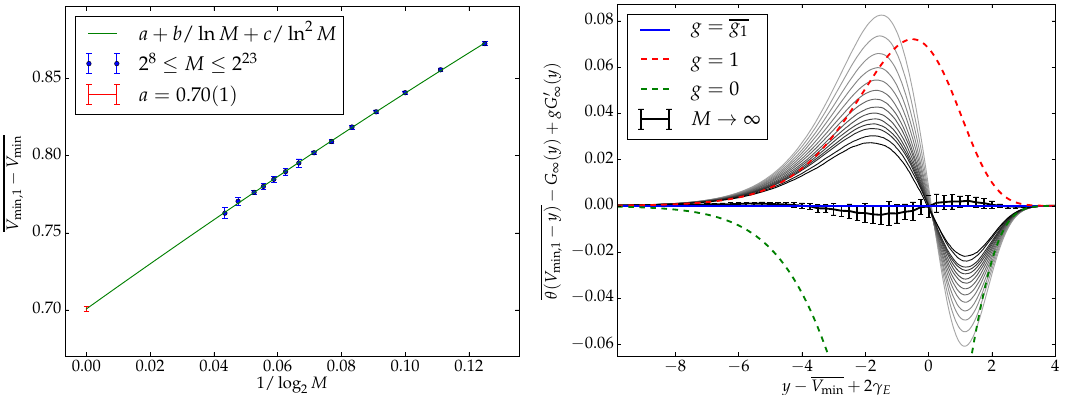
Figure 2: Left: the numerical measure of the mean of first gap, as function of system size (points), is well described by a quadratic finite-size Ansatz a + b / ln M + c / ln 2 M . We use it = a = 0.70 ( 1 ) . Right: The cumulative distribution function to extract the M → ∞ value g 1 of the second minimum V of the circular 1 / f -noise model, with the theoretical prediction min,1 (39) extracted, and the parameter g = g fed by the previous measure. The grey curves are 1 numerical data with system size 2 8 ≤ M ≤ 2 23 , and the extrapolation to M → ∞ (black curve) by applying the quadratic Ansatz pointwise. The error bars combine the distribution error with that g For comparison (39) with other values of g are plotted in dash 1